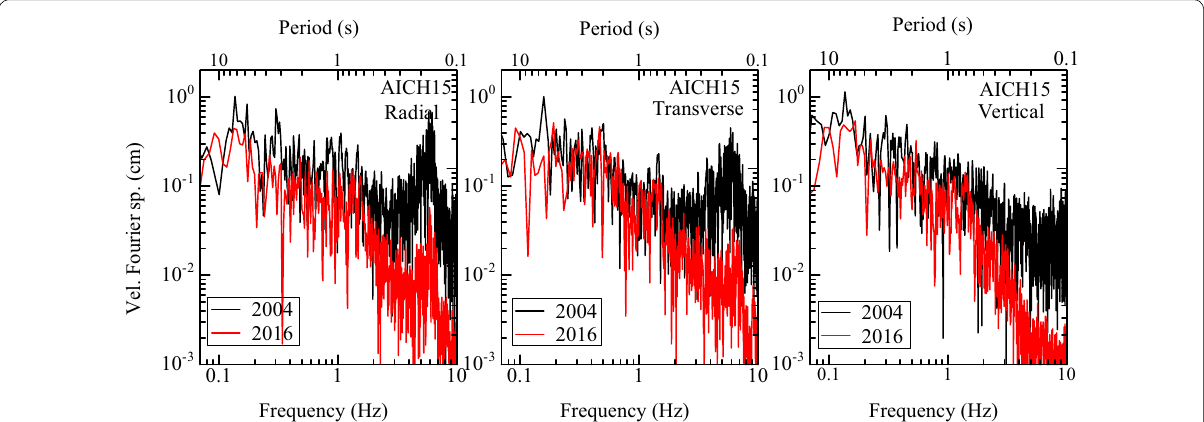
Fig. 8 Plot of radial (left panel), transverse (middle panel), and vertical (right panel) component velocity Fourier amplitude spectra at the AICH15 site (see Fig. 1 for location) for the 2004 (black curve) and 2016 (red curve) events. See Fig. 7 for the bandpass-filtered velocity seismograms and Fig. 6 for the accelerograms at the site